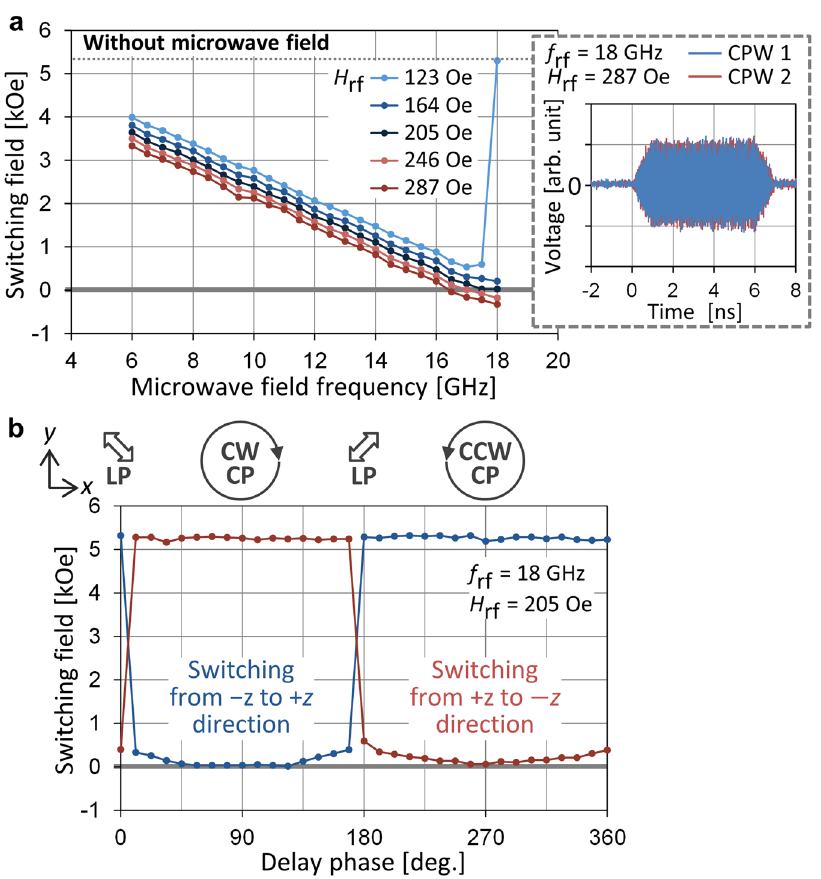
Figure 3. ( a ) H versus f in the circularly polarized microwave field from CPWs 1 and 2 for several H sw rf values. The inset shows a waveform of signals with 1-ns rise/fall time and 5-ns plateau time measured at the cable end connected to the CPWs. ( b ) H versus delay phase of the signal in CPW 2 with respect to that in sw CPW 1 for Oe. Schematics at the top depict polarization of the generated microwave field. Two curves correspond to the cases in which the nanomagnet reverses from the − z to + z directions and from the + z to − z directions,